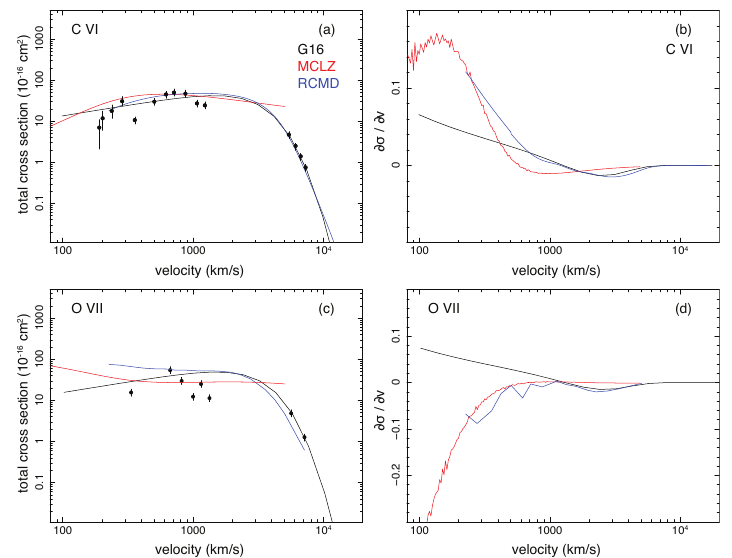
Figure 1. Total cross sections as a function of collision velocity and the cross section derivatives with respect to the velocity for C 6 + ( a , b ) and O 7 + ( c , d ) ions interacting with hydrogen atoms, resulting in C VI and O VIII ions. The data points are experimental results from Goffe et al. [40], Phaneuf et al. [41], Panov et al. [42], and Meyer et al. [43]. Approximate errors of 15% [43] are shown, except for the low energy (<500 km s − 1 ) data of C VI, for which the actual errors were reported in the original paper. The solid lines are the model values from the calculations with the G16 (black), MCLZ (red), and RCMD (blue) methods. The abbreviations are explained in the text.